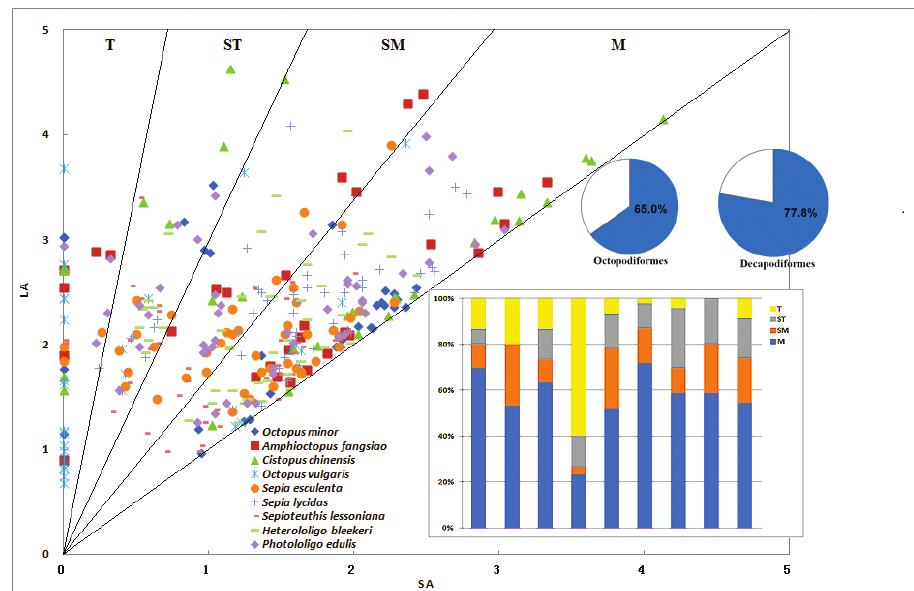
Figure 4. Chromosome distribution diagram of nine species of cephalopods. The slopes of the four lines are 1, 1.7, 3 and 7, dividing the diagram into four zones which represent four types of chromosome. SA, short arm relative length; LA, long arm relative length; M, metacentric; SM, submetacentric; ST, sub- telocentric; T, telocentric. The blue area of pie charts and bar charts means M+SM and M,